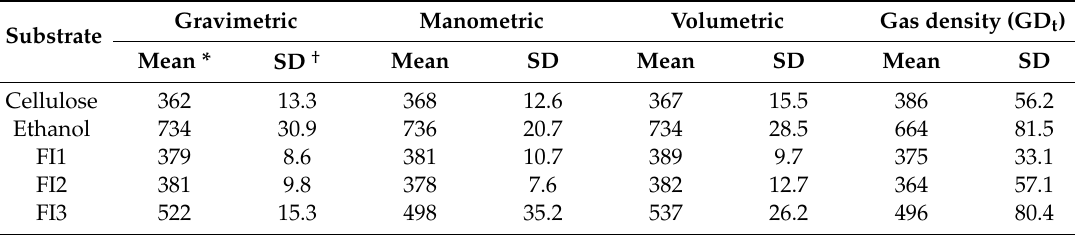
Table 2. Gas density, gravimetric, manometric, and volumetric estimates of BMP (all in mL g − 1 ) for five substrates from Experiment 1A. The duration was 31 days for all bottles, and n = 3 bottles except for cellulose and inoculum-only ( n = 2) where one bottle from each was excluded because of leakage. Gravimetric Manometric Substrate